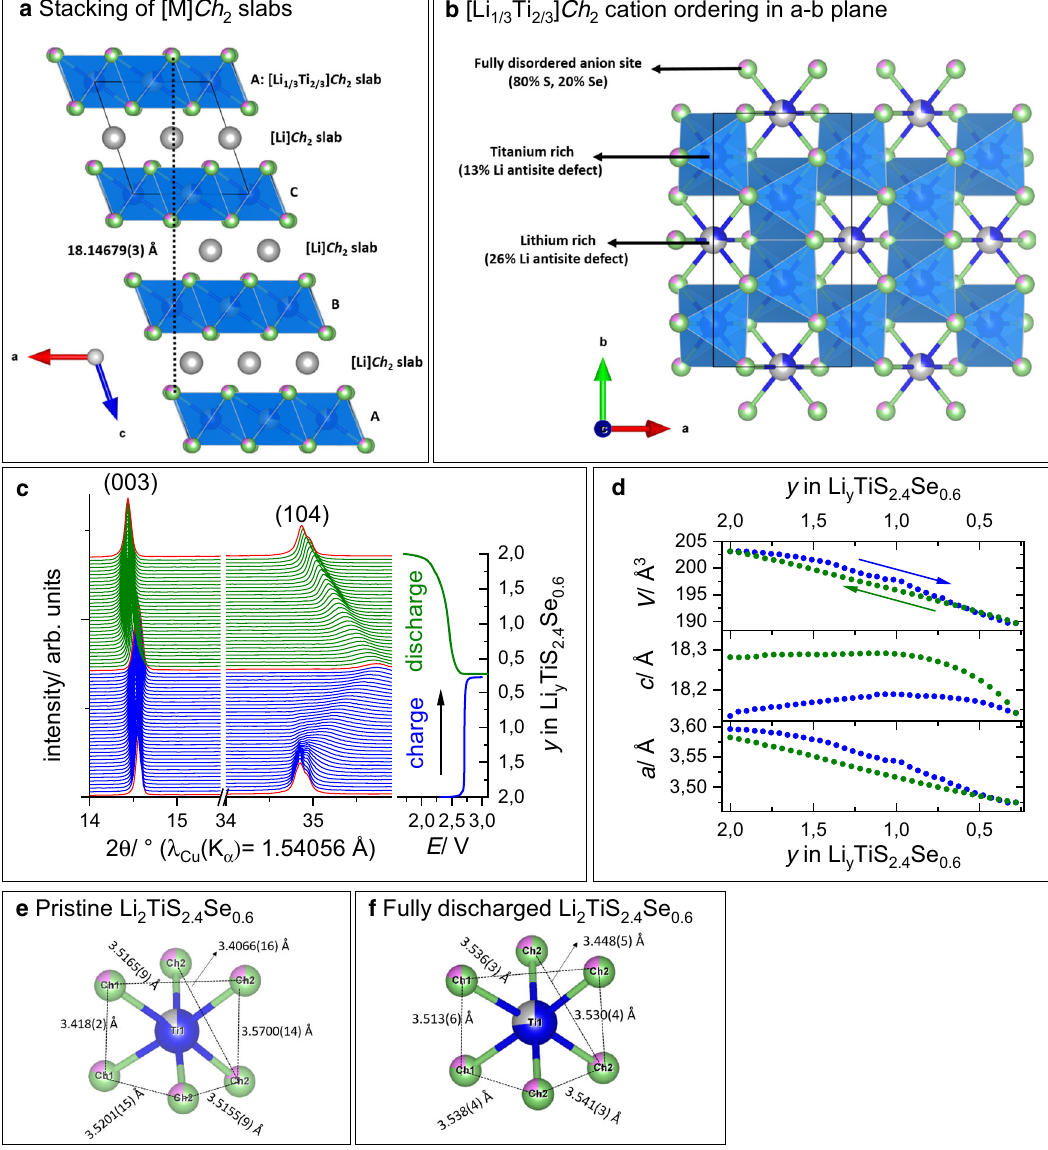
Fig. 3 Crystal structure of Li y TiS 2.4 Se 0.6 . a Structure of Li 2 TiS 2.4 Se 0.6 shown along the stacking axis: Li and Ti occupy all octahedral interstices present in the cubic close packing of Ch 2 − anions. Partial ordering of the cations leads to the formation of [Li] Ch 2 and [Li 1/3 Ti 2/3 ] Ch 2 layers. b Representation of the mixed [Li 1/3 Ti 2/3 ] Ch 2 slab: the partial ordering of Li vs Ti. c Evolution of the PXRD patterns of Li y TiS 2.4 Se 0.6 during the 1st cycle of an operando PXRD experiment. d Corresponding evolution of the lattice parameters of Li y TiS 2.4 Se 0.6 (space group: R (cid:1) 3 m ). e , f Local bonding environments around Ti1 of pristine Li 2 TiS 2.4 Se 0.6 and fully discharged Li 2 TiS 2.4 Se 0.6 (color code: blue: Ti, gray: Li, green: S, pink: